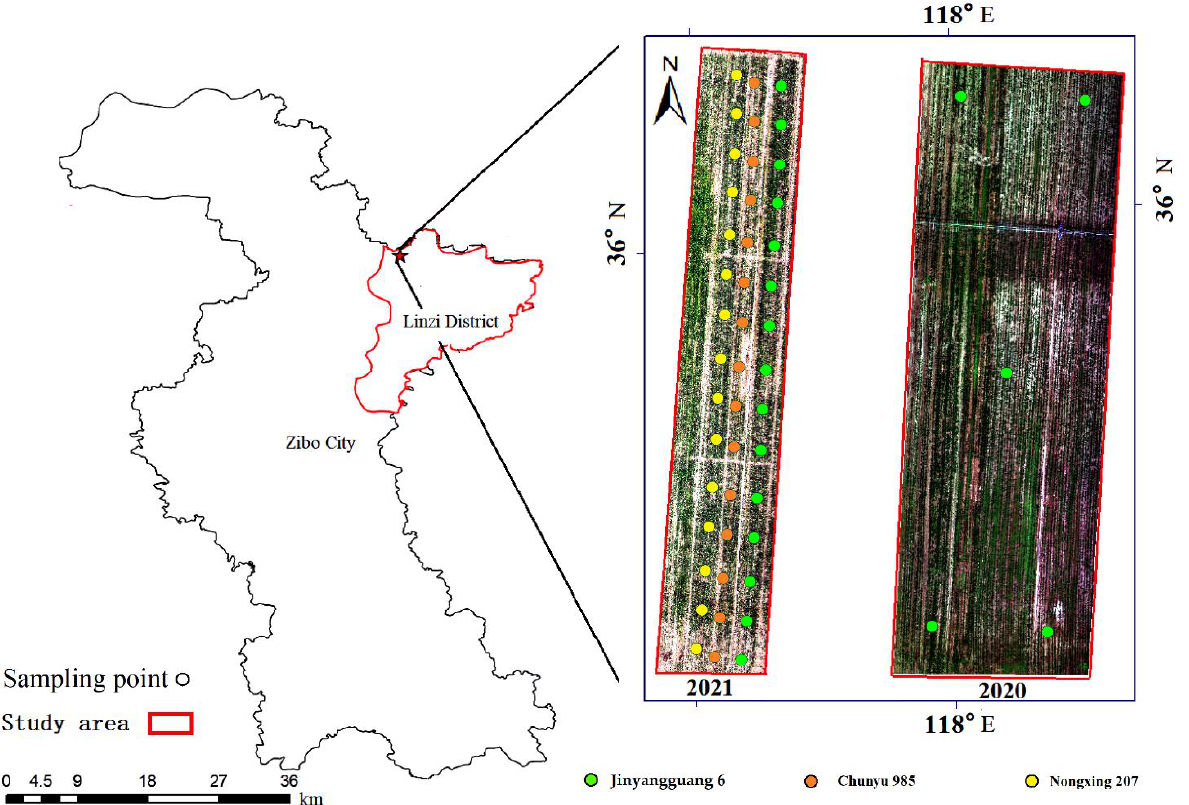
Figure 1. Sampling area